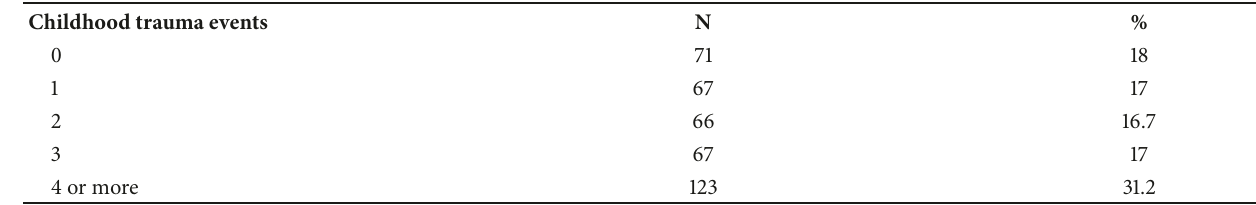
Table 2: Frequency of psychiatric comorbidities according to mini in 394 primary care patients with depression, Maule region, Chile, 2014. Comorbid diagnosis N Post traumatic stress disorder (PTSD)